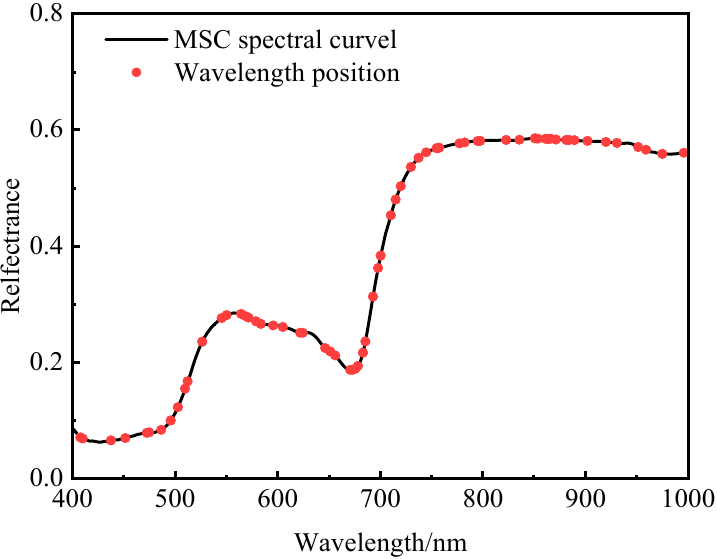
Figure 12. Characteristic wavelengths of the MSC spectral curve selected using the PSO algorithm.